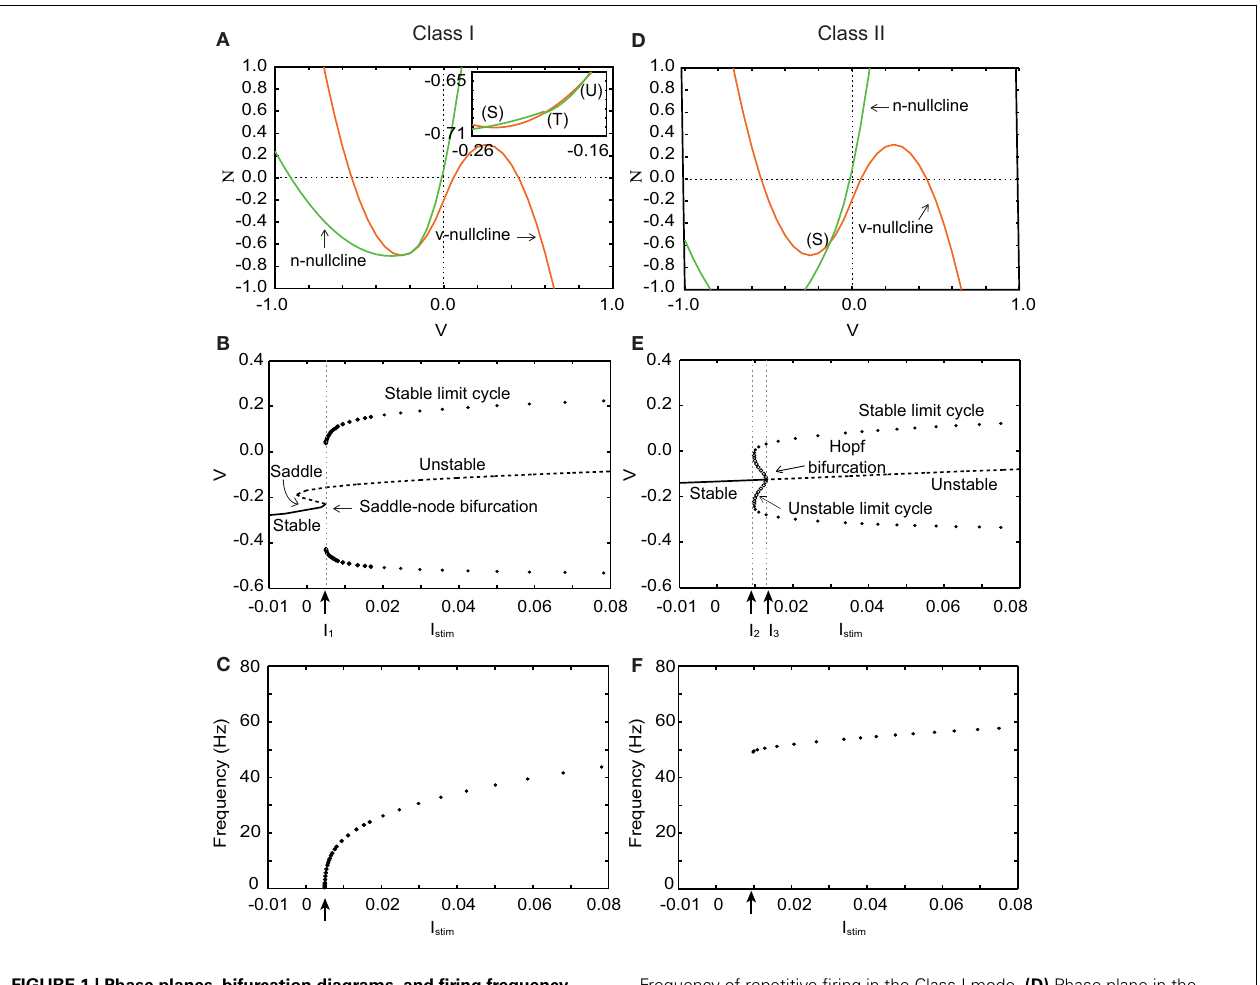
FIGURE 1 | Phase planes, bifurcation diagrams, and firing frequency of our silicon neuron model in its Class I and Class II modes. (A) Phase plane in the Class I mode. I stim = 0. (B) Bifurcation diagram in the Class I mode, where the bifurcation parameter is I stim . I 1 = 0.005. (C)